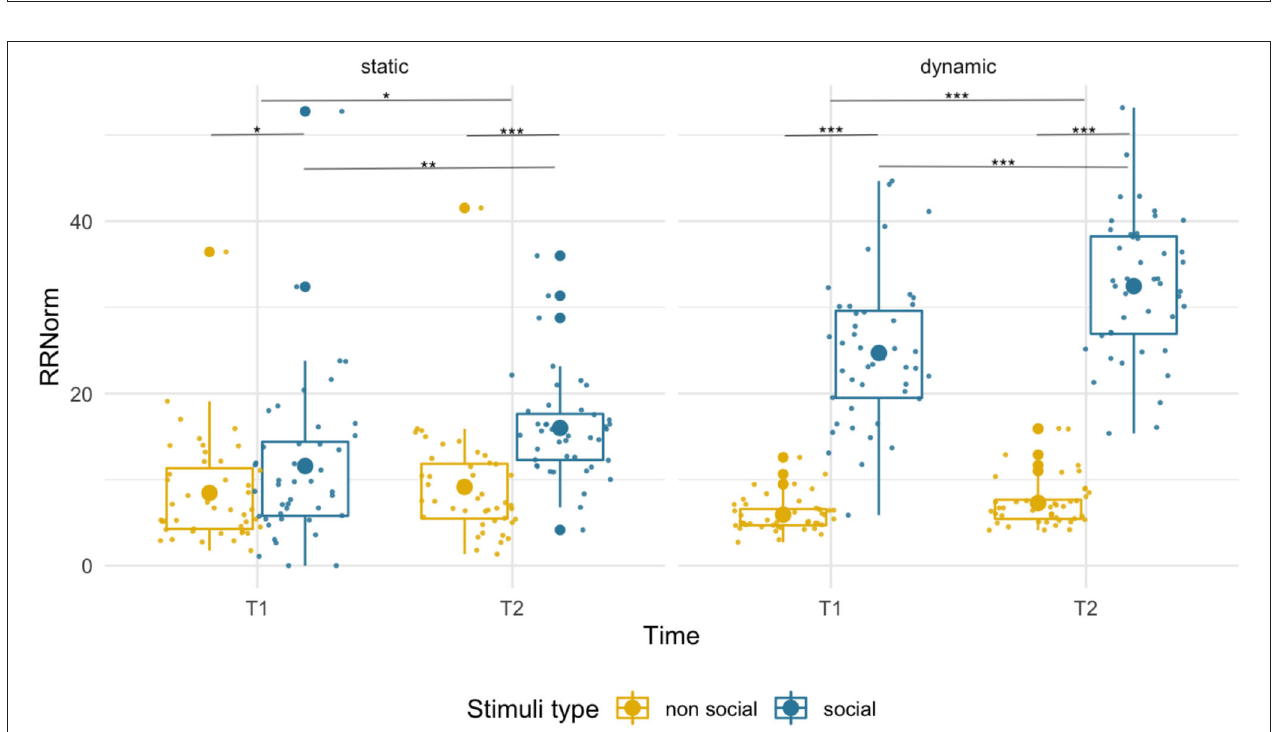
FIGURE 1 | Example of an RQA plot (A) and its original fixation coordinates for a social visual scene (B) . The blue ellipse represents deterministic fixations sequences where fixations 7, 8, and 9, recurred with fixations 13, 14, and 15 The green ellipse square shows consecutive patterns of fixations (fixations 7-8 and 13-14) at the same location. The red square in (A) represents all the fixations that fall within a 64 pixel radius of fixation 4 (see black circle in B ). This plot comes from the data of one participant.